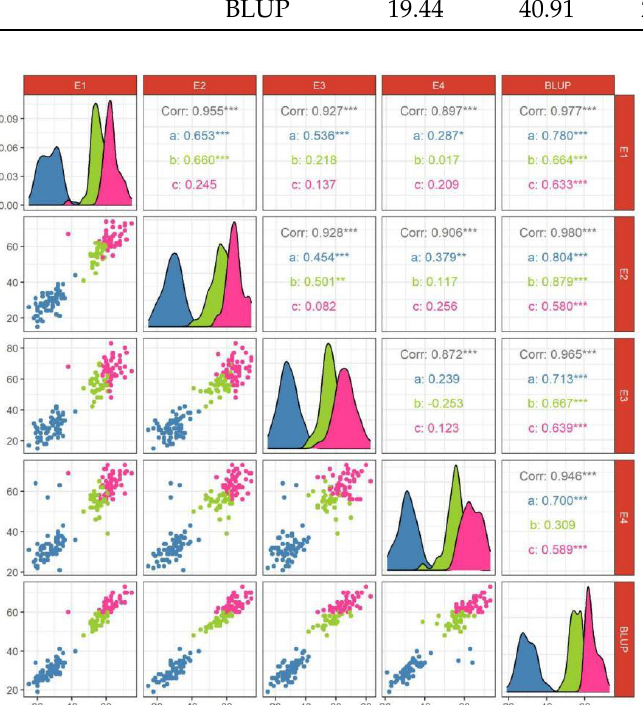
Table 2. Analysis of variance of HI trait in 150 wheat accessions. Type